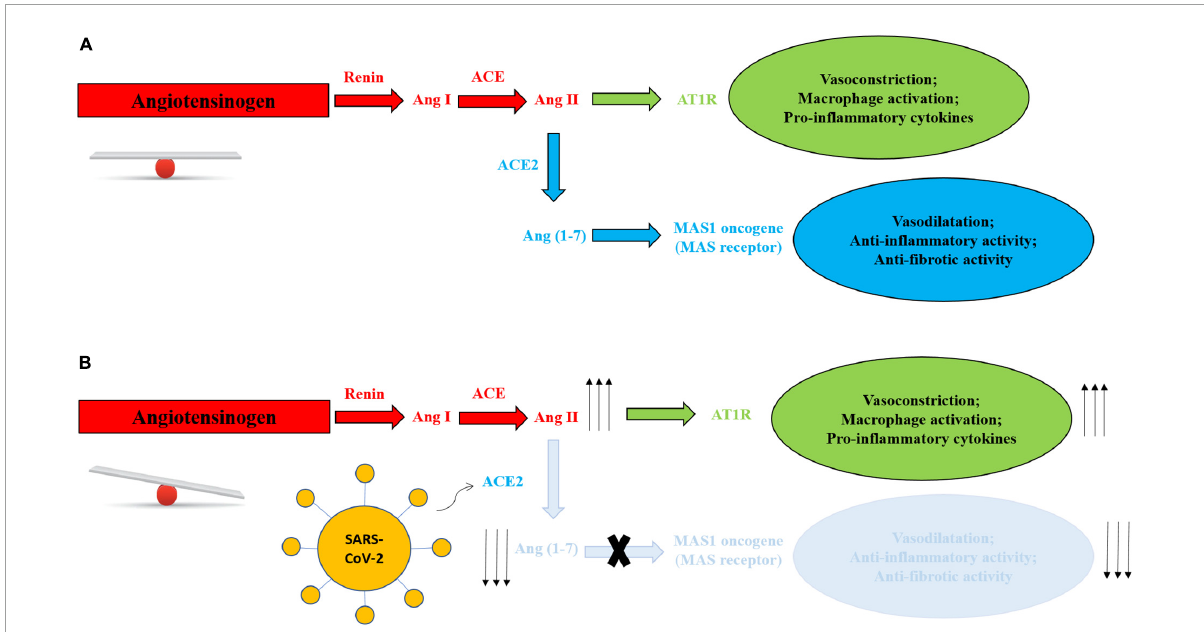
FIGURE1 (A) Balanced RAS system in absence of SARS-CoV-2. (B) RAS system mechanism unbalance in presence of SARS-CoV-2. Virus entry leads to degradation of membranal ACE2 with depletion of Ang 1–7, blunting role of the Ang (1–7)/MAS axis and reducing its physiological and protective activities, and increasing Ang II-AT1R production and activities, with vasoconstriction, activation of macrophages and increase in inflammatory cytokines.